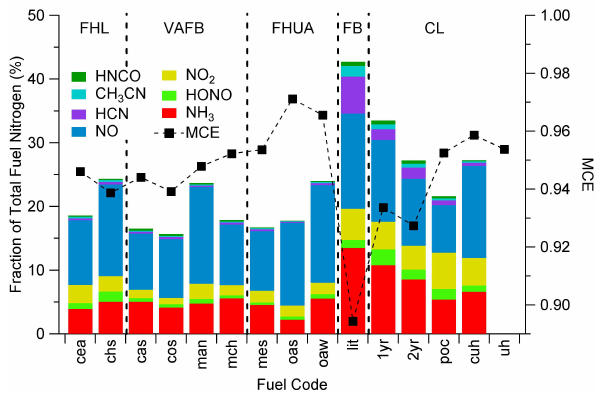
Fig. 6. Spectral confirmation of the presence of HONO in labo- ratory biomass fires. The upper spectrum is the residual of an ac- tual OP-FTIR spectrum after quantification and subtraction of all species that absorb in this spectral region with HONO omitted from the fit. The lower blue trace is the HONO reference absorption spec- trum provided by Pacific Northwest National Laboratories (Sharpe et al., 2004), de-resolved to match the OP-FTIR resolution (there are a few water peaks remaining in the residual spectrum due to its variability and high